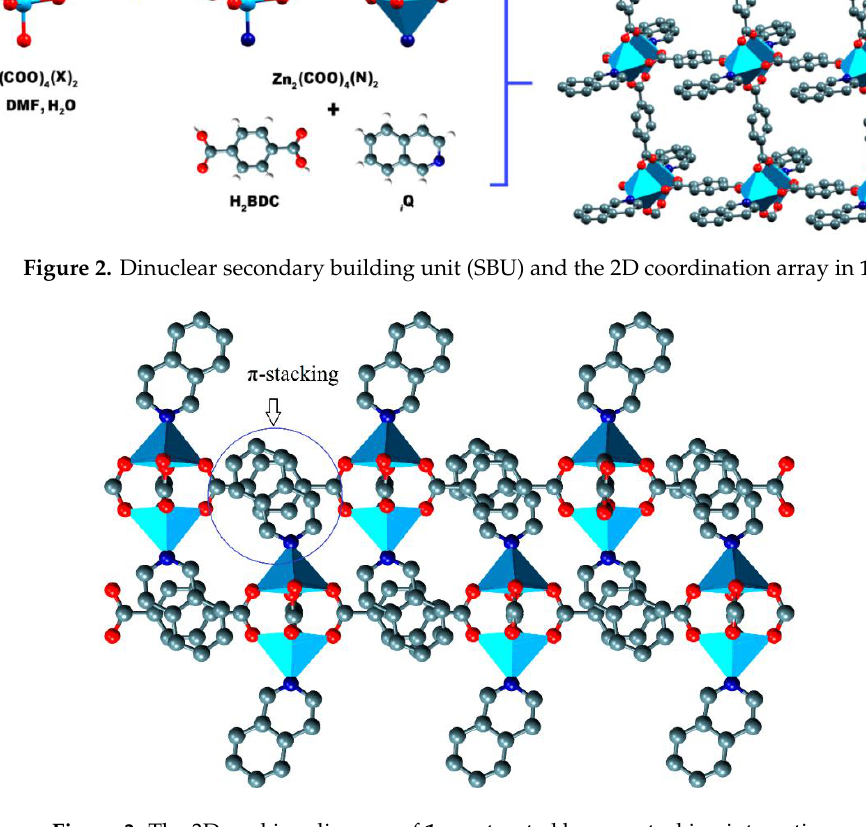
Figure 3. The 3D packing diagram of 1 constructed by π–π stacking interactions .